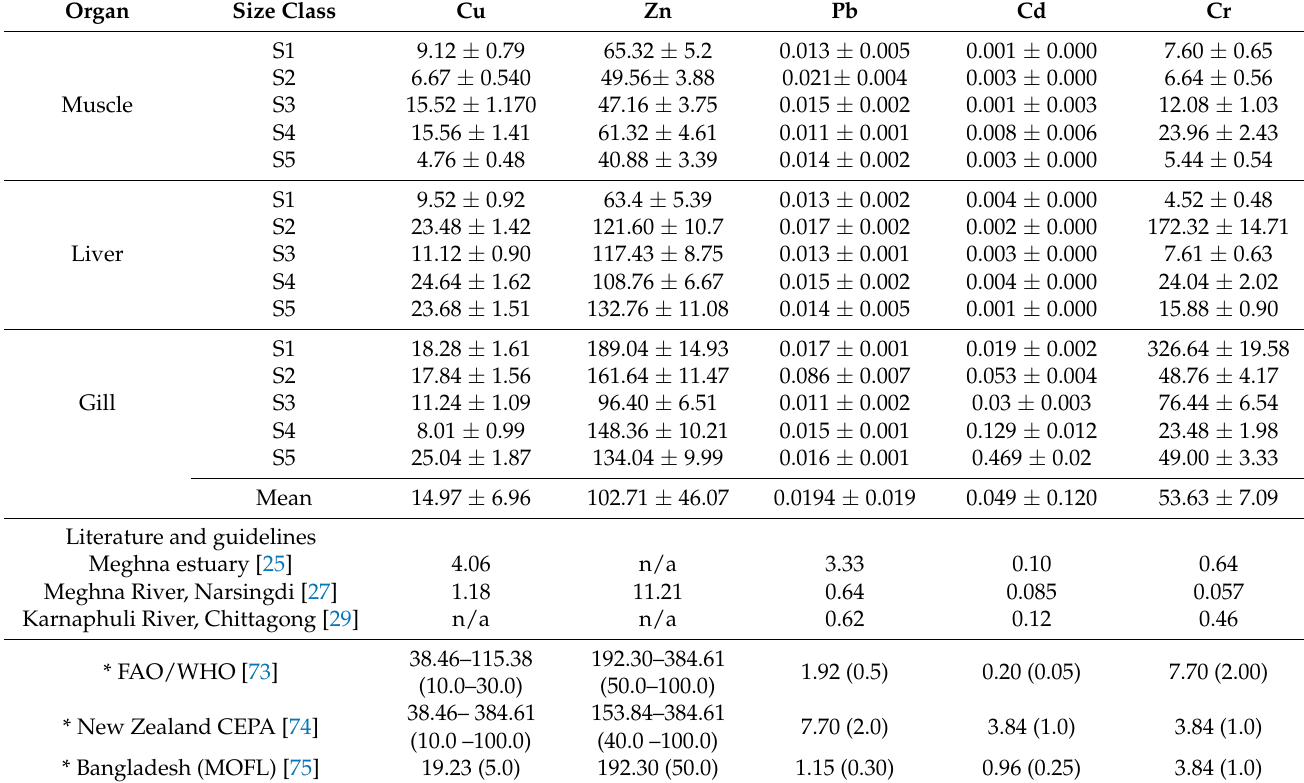
Table 2. Concentration (Mean ± SD) of heavy metals ( µ g g − 1 dry weight) in muscle, liver, and gills of the five size